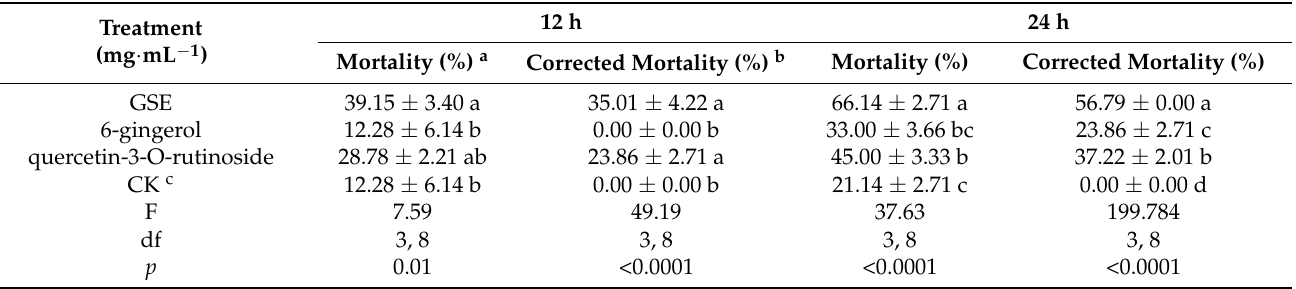
Table 3. Mean mortality ( ± SE) of M. sorghi after 12 h and 24 h of treatment with ginger shoot extract, 6-gingerol, and